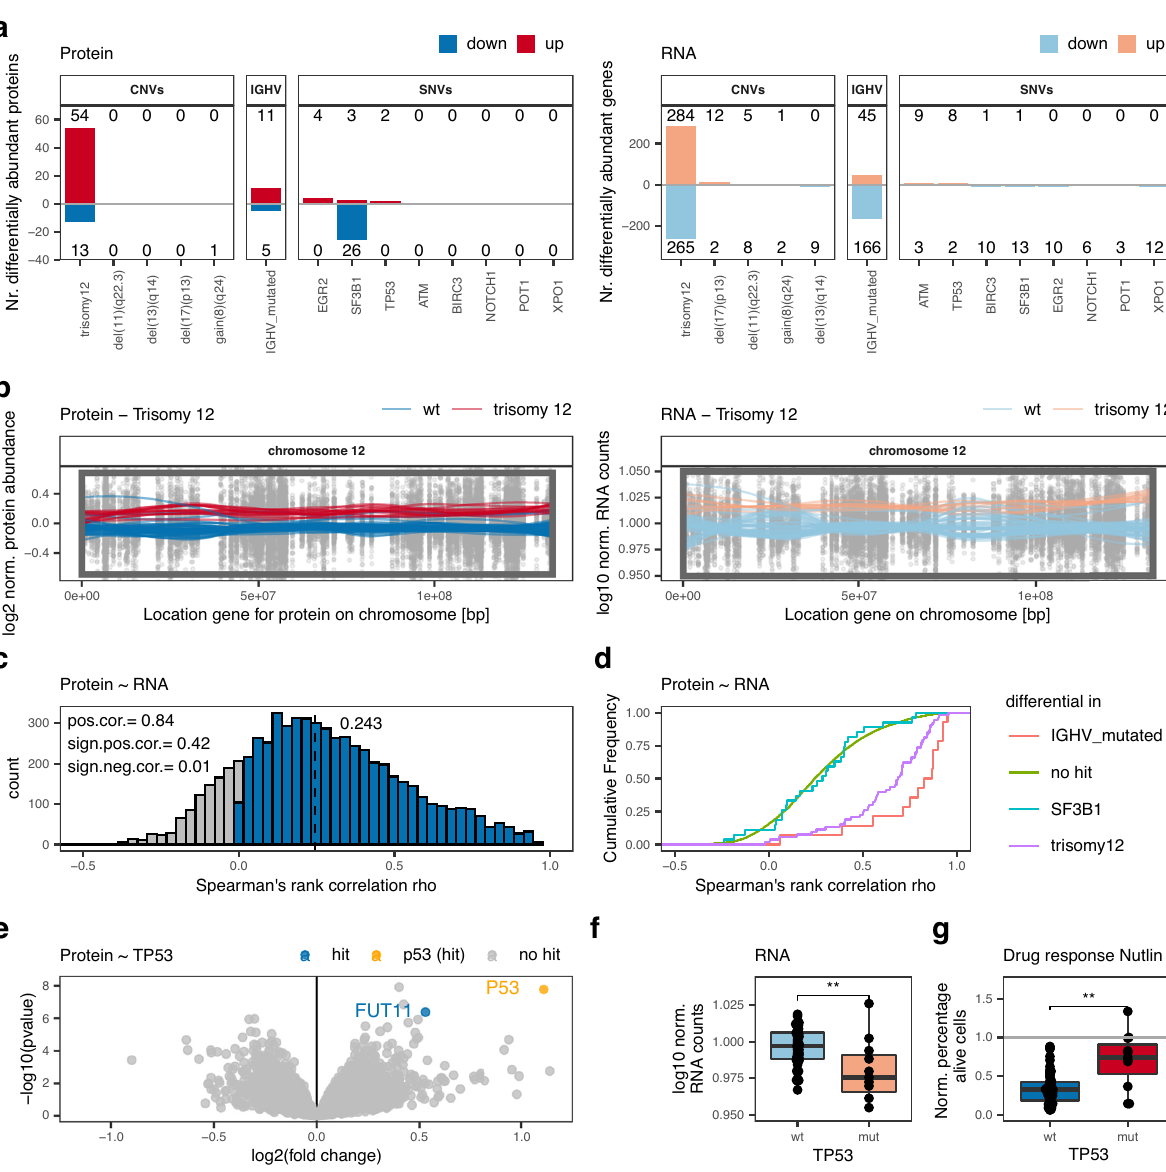
12 (pink) or SF3B1 -mutated (blue) CLL in comparison to all other proteins without these associations (green). e Volcano plot indicating differential proteins in TP53 mutated in comparison to TP53 wild-type CLL; hit = adjusted p <0.001, |log2FC| >0.5. P values calculated by limma. Multiple testing correction by FDR to identify hits. f TP53 transcriptlevels in TP53 mutated(mut, n =11) and wild-type(wt, n =47) biologically independent CLL samples; two-sided Wilcoxon signed-rank test p =0.005. g Percentages, normalized to solvent control, of alive cells of TP53 mutated (mut, n =56) and wild-type (wt, n =11) biologically independent CLL samples treated ex-vivo with 9 µ M nutlin 3a; two-sided Wilcoxon signed-rank test, p =0.0019.Boxplotsarerepresentedas fi rstandthirdquartileswithamedianinthe center. Whiskers are de fi ned as 1.5 times the interquartile range ( f and g ). Source data are provided as a Source Data fi